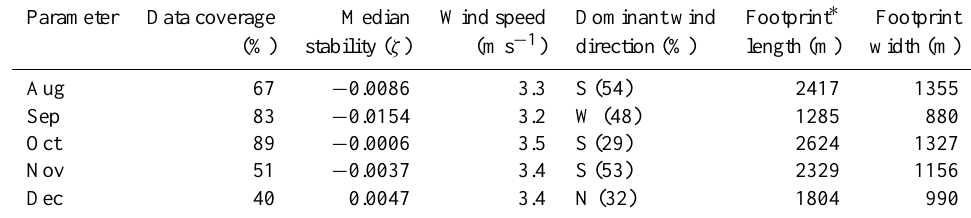
Table 3. Summary of site meteorology by month in central London during 2012. Parameter Data coverage Median Wind speed Dominant